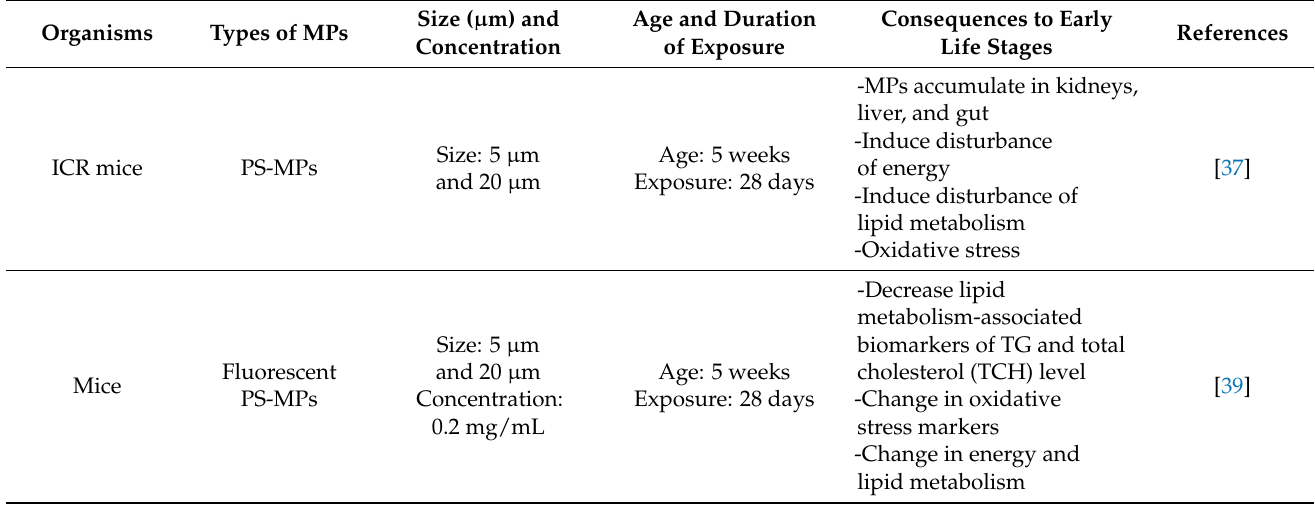
Table 1. Summary of the effects of MPs exposure on the digestive system during the early develop- mental